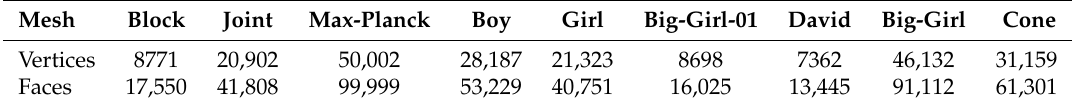
Table 2. The numbers of vertices and faces of the meshes tested in Section